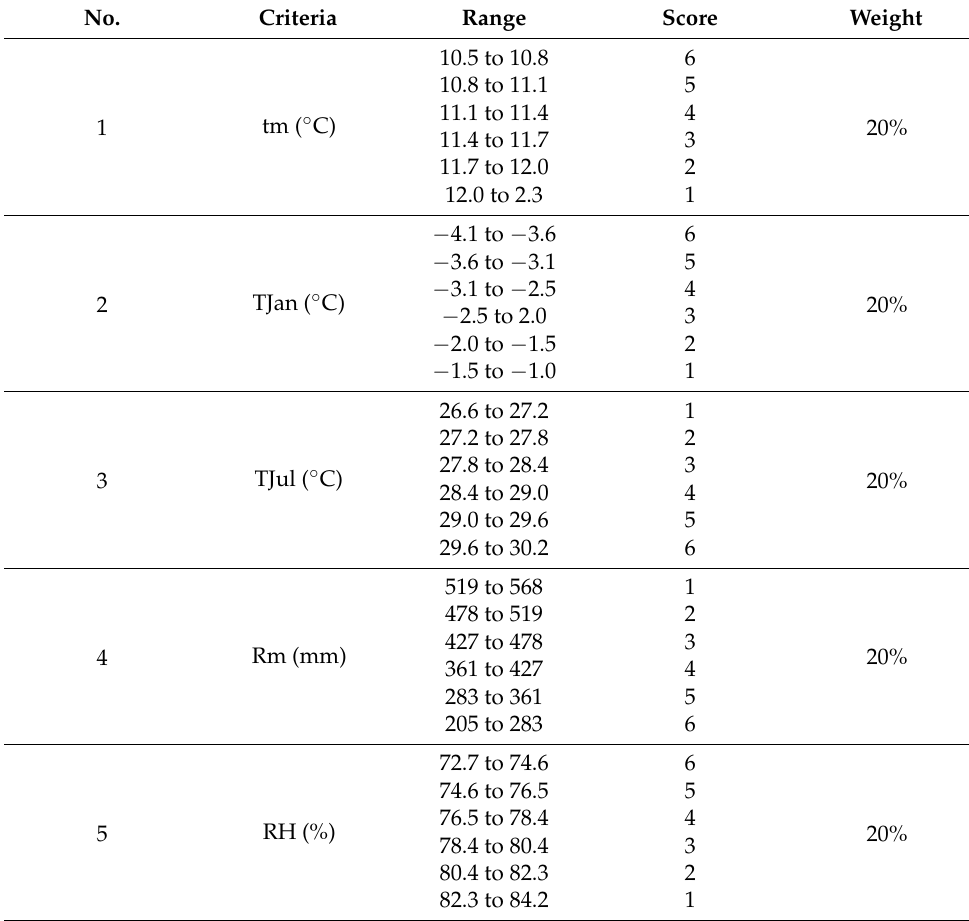
Table 4. Scores assigned to the climatic parameters.